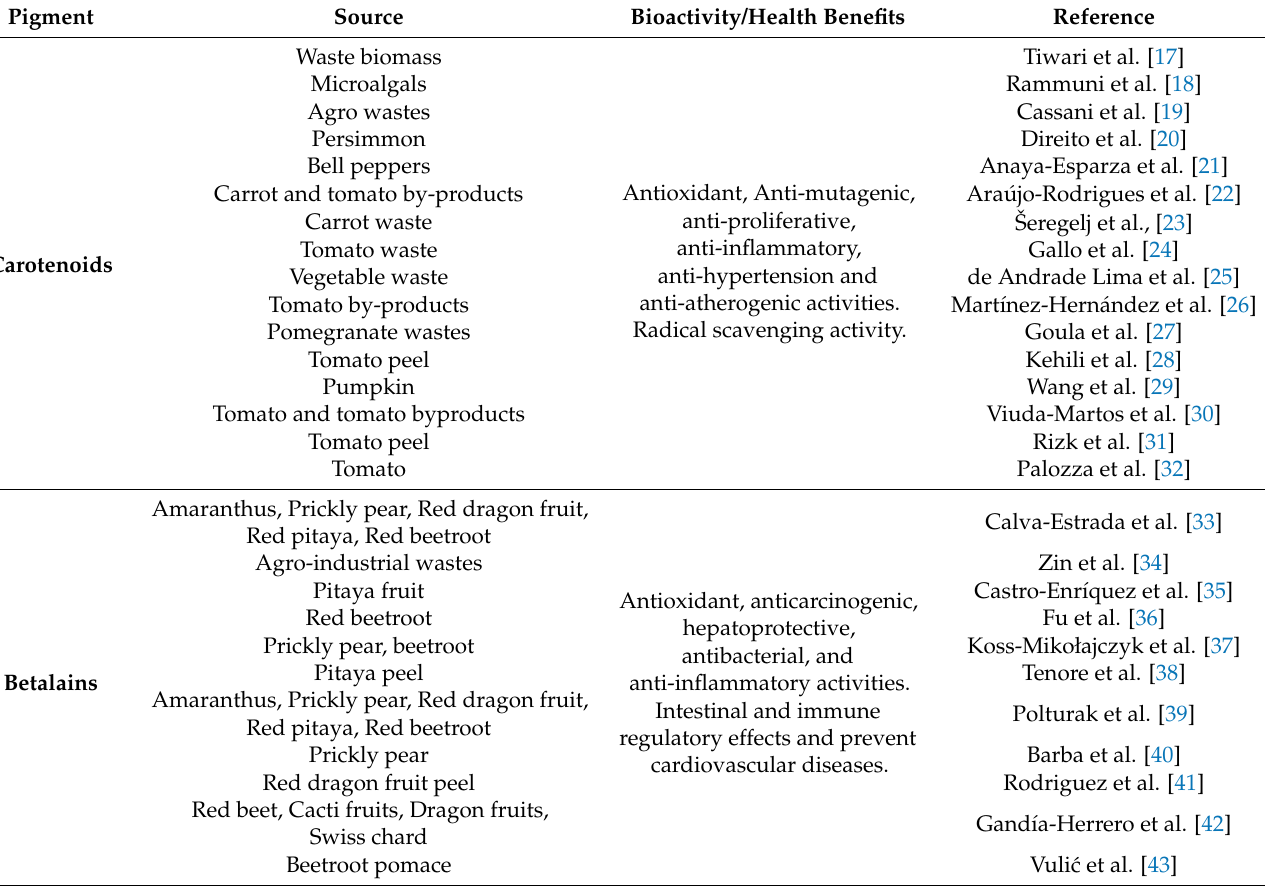
Table 1. Studies on the bioactivity and health effects of carotenoids and betalains from vegetable sources.